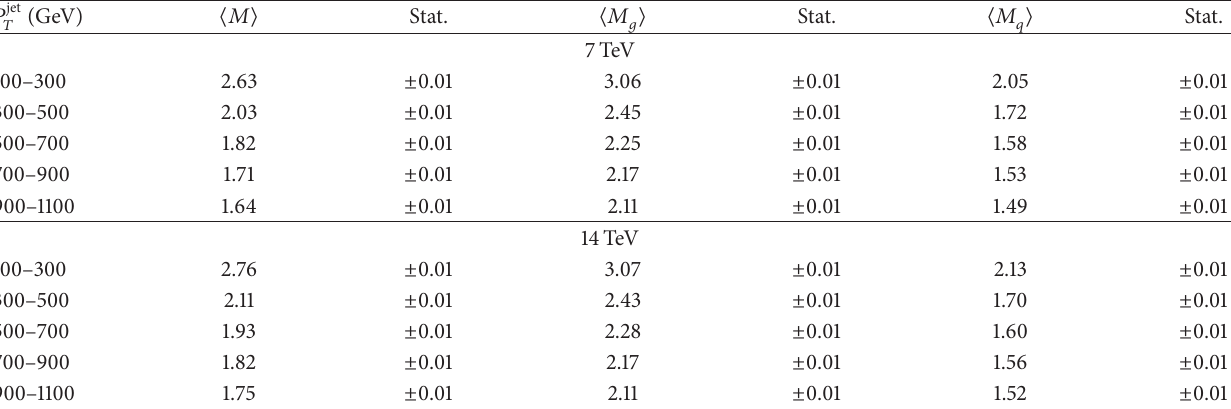
Table 3: Average subjet multiplicities as a function of 𝑃 jet 𝑇 (GeV) for mixed jets and jets matched to gluons and quarks, for 𝑘 𝑇 algorithm at √𝑠 = 7TeV and √𝑠 = 14TeV.